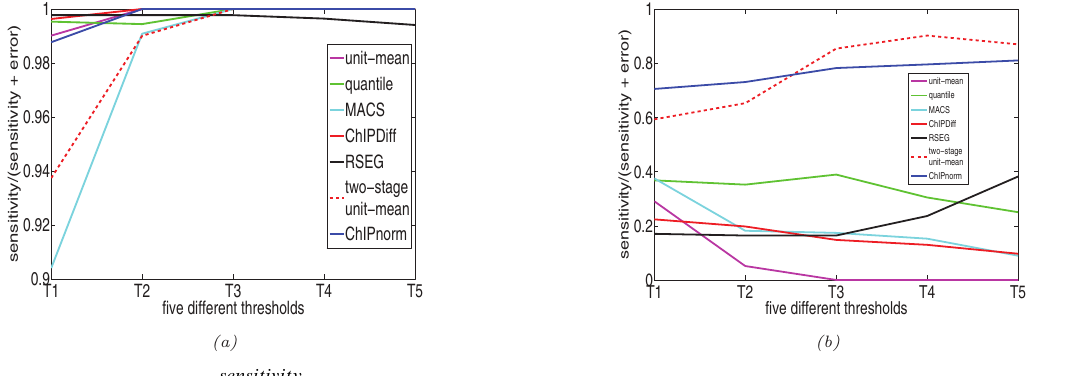
sensitivity over five different threshold values. (a) NP is differentially over-expressed compared to Figure 7. Plot of ( sensitivity z error ) ES, (b) ES is differentially over-expressed compared to NP.